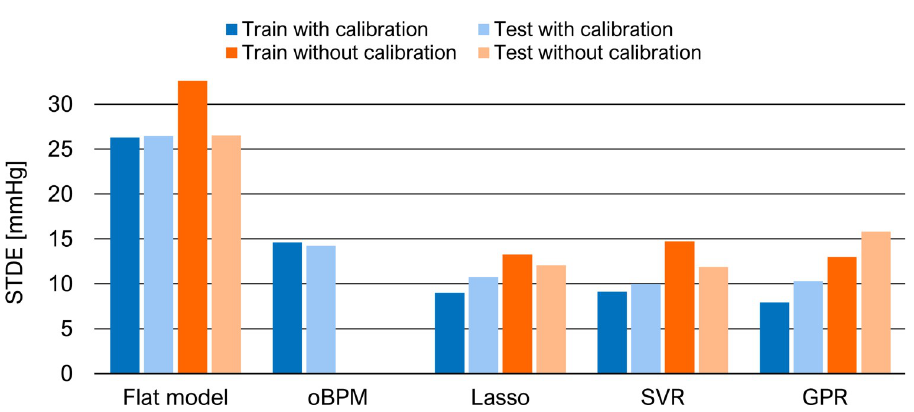
Fig 5. Performance of different ML models in term of STDE in mmHg for SBP estimation with and without calibration.